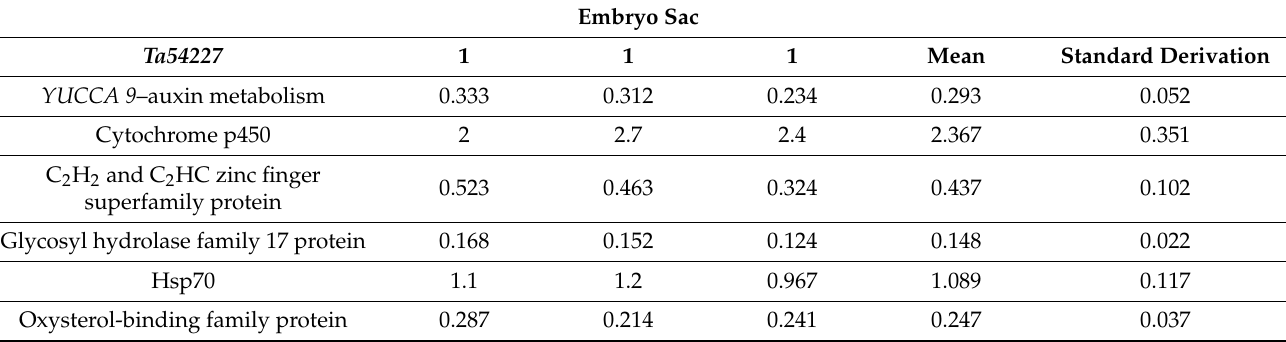
Table 3. The gene expression levels in the cells of the embryo sac.